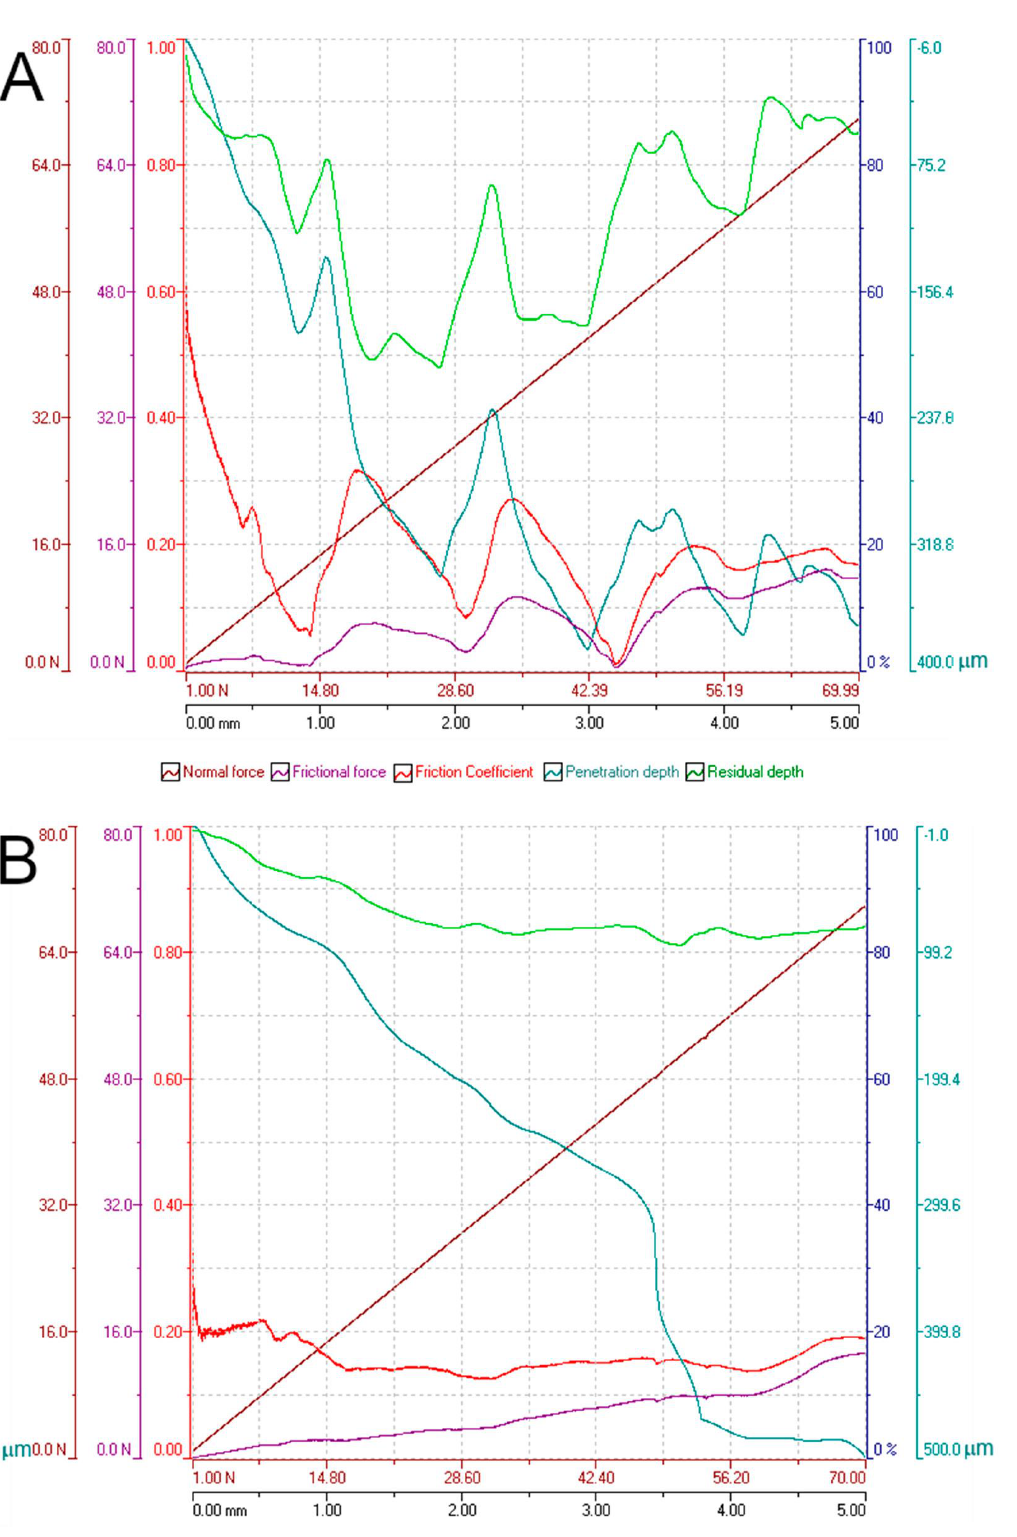
Figure 17. Micro scratch test results: ( A ) perpendicular to the printing direction; ( B ) parallel to the printing